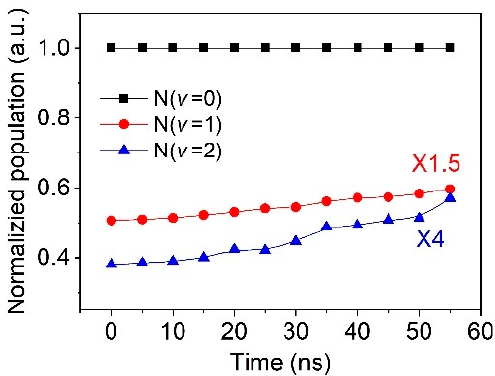
Figure 7. Temporal dependence of the relative vibrational populations of N 2 (C 3 Π u , v = 0), N 2 (C 3 Π u , v = 1), and N 2 (C 3 Π u , v = 2).